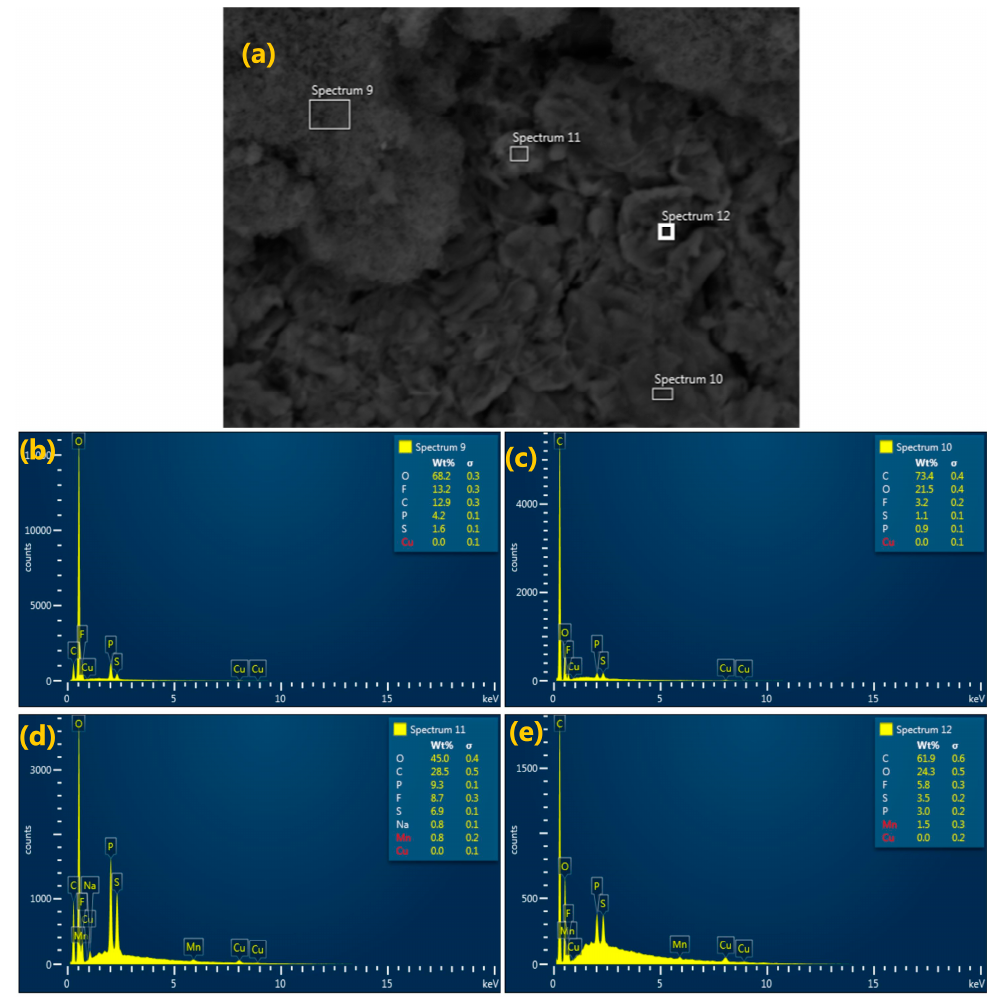
Figure 9. ( a ) EDS analysis of the chemical composition of the harvested anode at four locations; ( b – e ) the localized volumetric analysis of the spectrum 9, 10, 11 and 12, respectively.